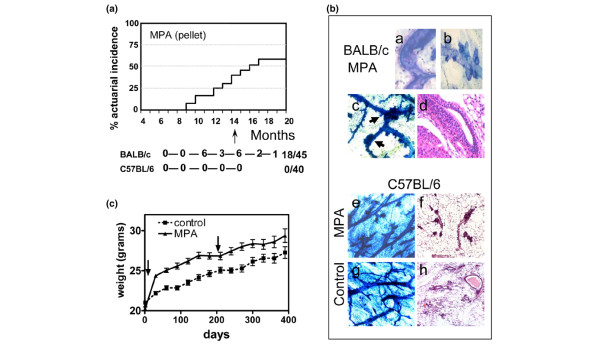
Tumor incidence, mammary gland alterations and body weight curves in MPA-treated mice. (a) Mammary tumor incidence. C57BL/6 mice were implanted with 40 mg MPA pellets that were replaced 6 months later; historical values of BALB/c using the same protocol were included for comparison. No mammary tumors appeared in MPA-treated or control C57BL/6 mice; control mice were implanted subcutaneously with silastic pellets. (b) Mammary gland alterations in MPA-treated BALB/c and C57BL/6 mice after one year of MPA treatment. The subpanels show the following: (a) a distorted and rotated ductal structure that appears to be forcibly stretched in areas (WM); (b) hyperplasia in the form of irregular paraductal proliferation (WM); (c) atypical ductal side branching showing areas of neoplastic growth (arrows; WM); (d) hematoxylin and eosin showing ductal hyperplasia; (e,f) WM and hematoxylin and eosin pictures showing nearly normal mammary glands of MPA-treated C57BL/6 mice; and (g,h) WM and hematoxylin and eosin pictures of C57BL/6 control mice. (c) Body weight curves of C57BL/6 mice implanted with 40 mg MPA (first arrow) or control blank silastic pellets that were replaced after 6 months (second arrow). All animals were weighed weekly and the results expressed as mean ± standard error. MPA-treated animals showed an increase in body weight that was already evident after the second week of treatment (P < 0.001; two-way ANOVA). ANOVA analysis of variance; MPA, medroxyprogesterone acetate; WM, whole mount.